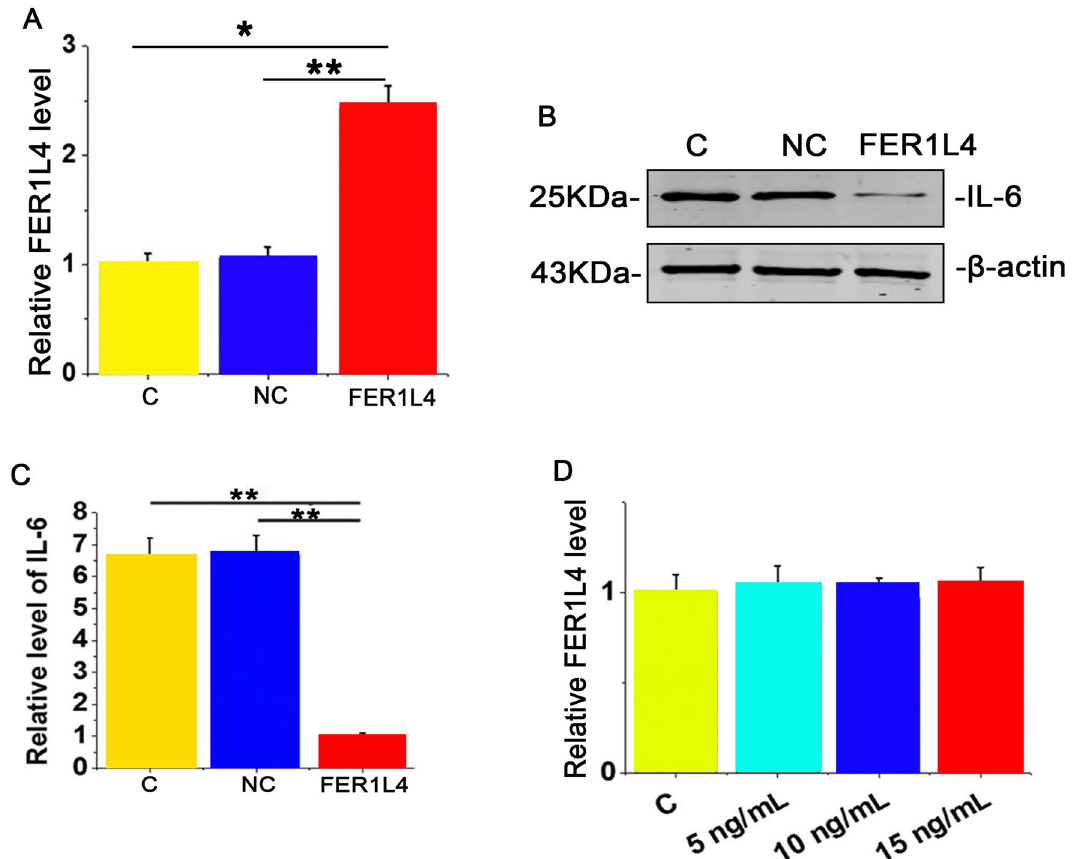
Figure 4. FER1L4 inhibited IL ‐ 6 expression in human chondrocyte cells. ( A ) qRT ‐ PCR results showing the relative expression of FER1L4 in human chondrocyte cells after FER1L4 or NC transfection. ( B–C ) Western blot results showing the expression of IL-6 in human chondrocyte cells after FER1L4 or NC transfection. ( D ) qRT ‐ PCR results showing the level of FER1L4 expression in human chondrocyte cells after treatment with IL-6. Data are represented as means ± SEM of 3 independent experiments. * P <